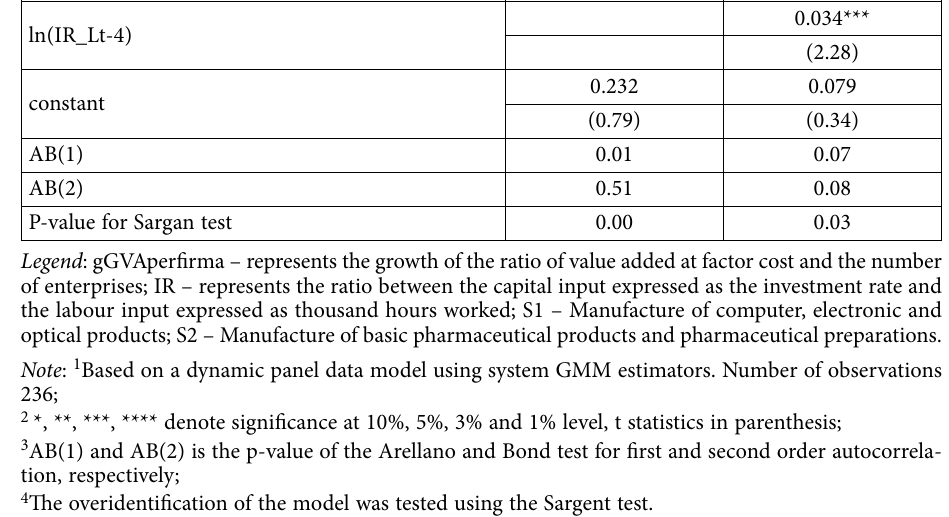
Table 2. Testing the beta convergence of gross value added in the high-technology manufacturing in- dustries, based on a dynamic panel model 1 (source: authors calculation using STATA 15) Dependent variable: ln(gGVAperfirm) S1 S2 ln(GVA per